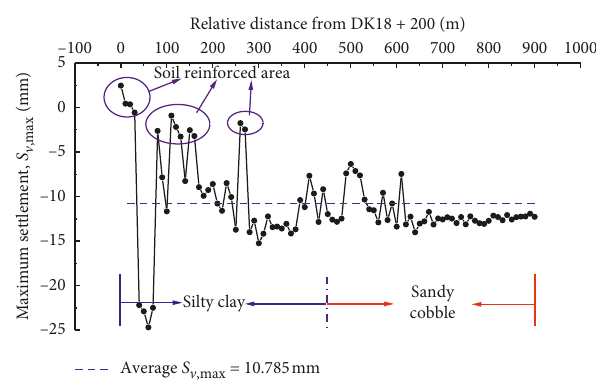
Figure 14: Maximum settlement of all monitoring points and average